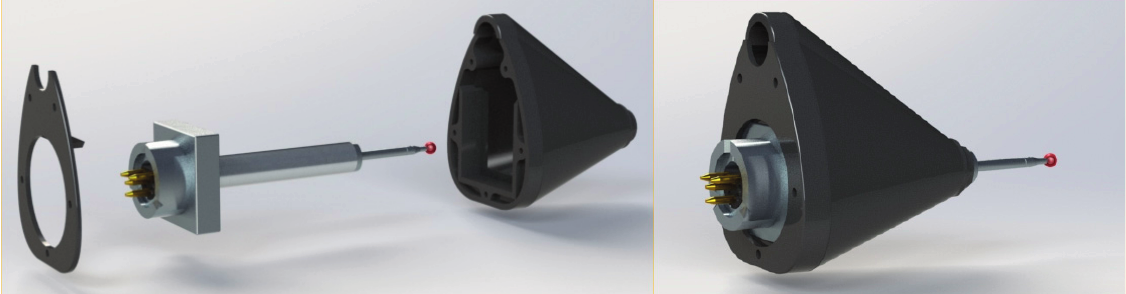
Figure 2. CAD detail design for the gauges’ protective